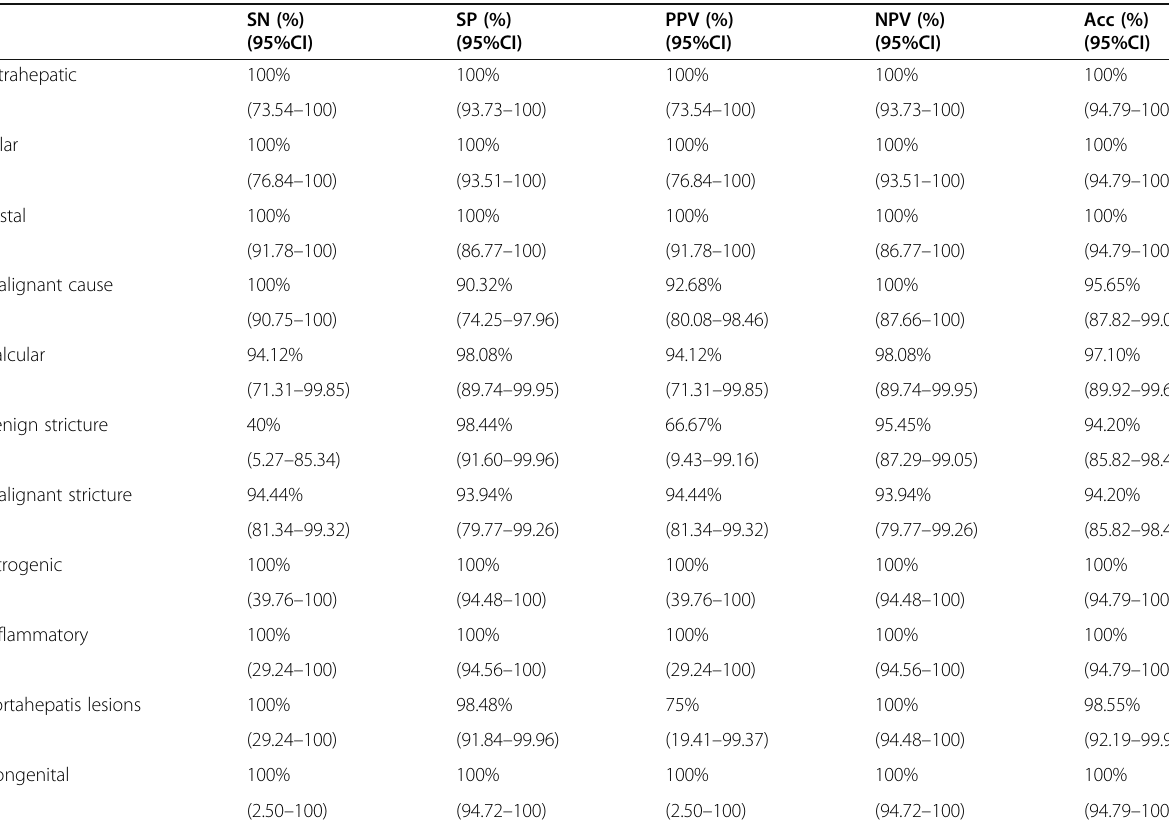
Table 8 Diagnostic performance of MDCT